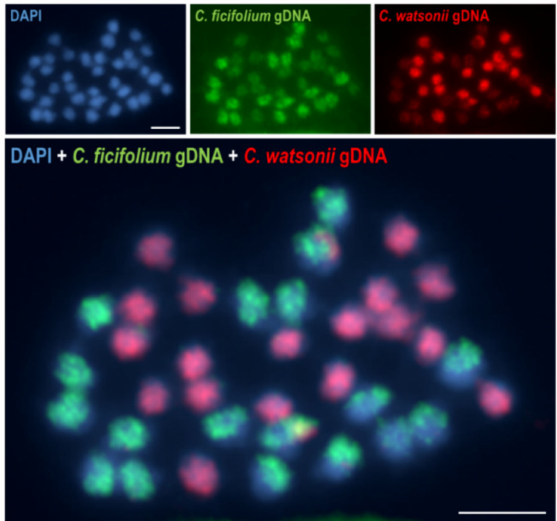
Figure 4. Mitotic metaphase chromosomes of the allotetraploid Chenopodium berlandieri (AABB) after double GISH with gDNA that had been isolated from the diploid C. ficifolium (BB; green fluorescence) and the diploid C. watsonii (AA; red fluorescence) based on [108]. Scale bars 5 µ